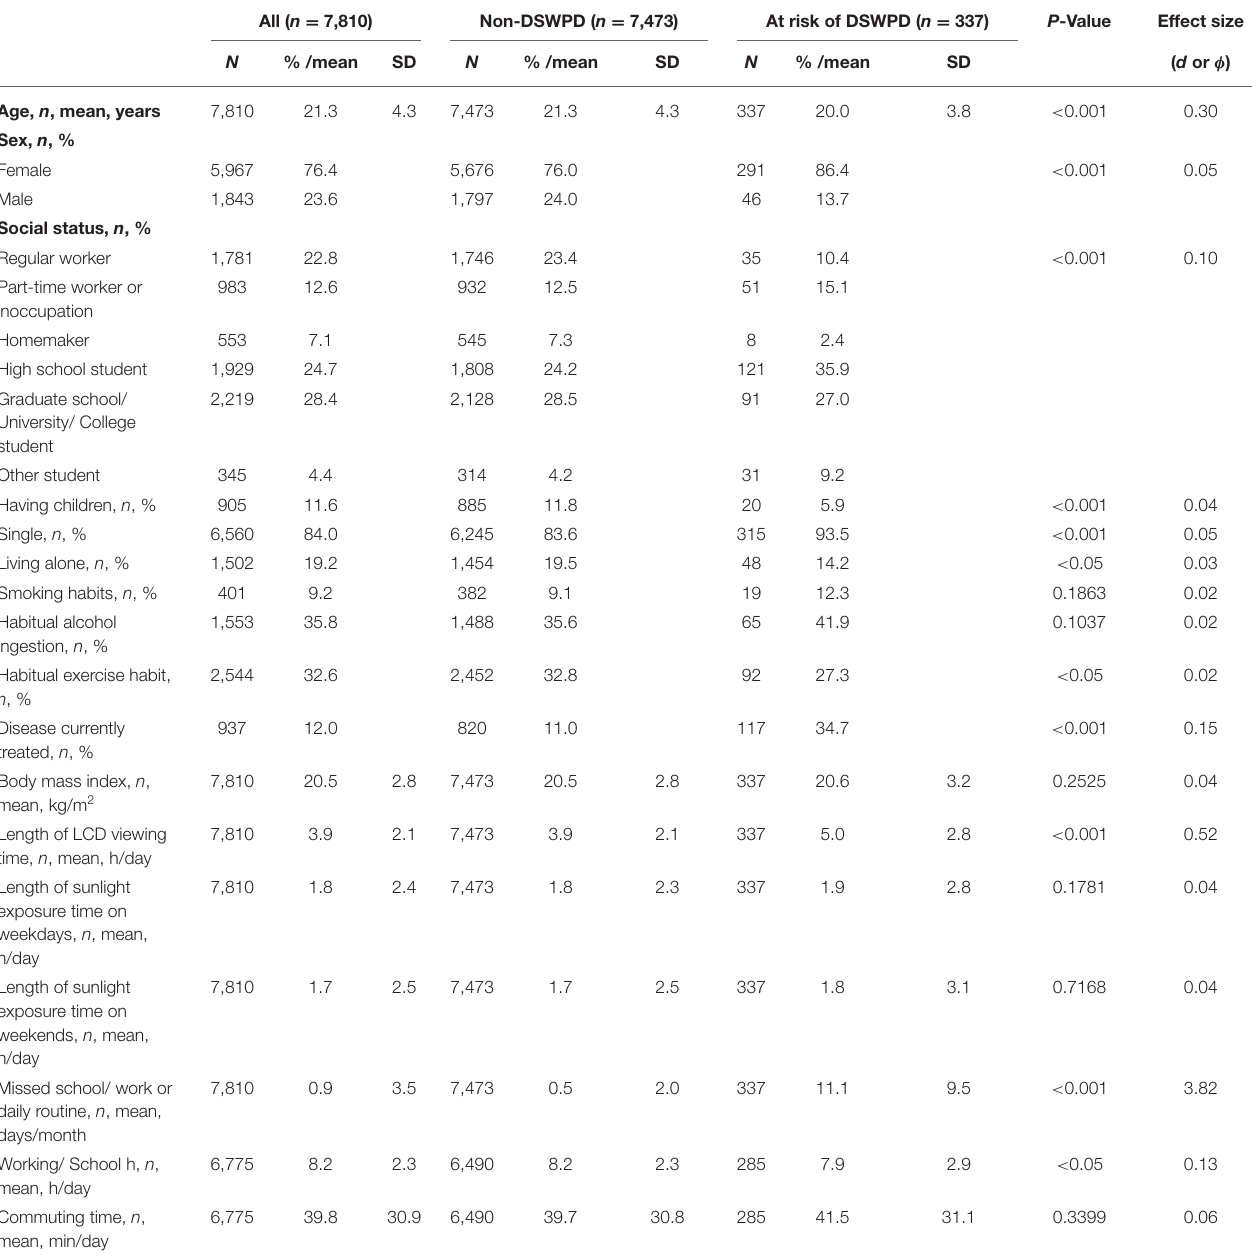
TABLE 1 | Descriptive variables of the studied population ( n = 7,810). All ( n = 7,810) Non-DSWPD ( n = 7,473) At risk of DSWPD ( n = 337) P -Value Effect size